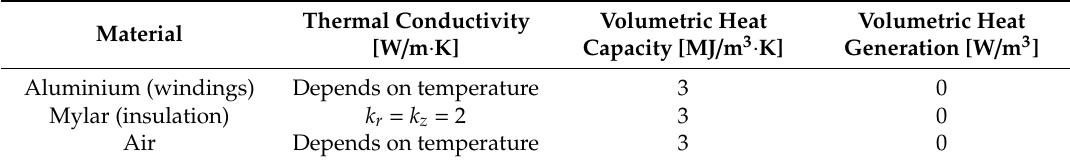
Table 7. Thermal simulation: Material